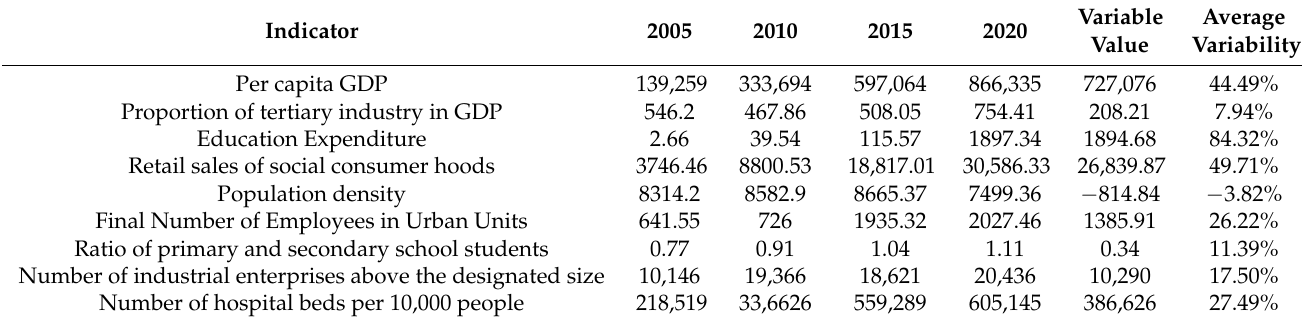
Table 5. Changes in the development of the elements of economic–social development in